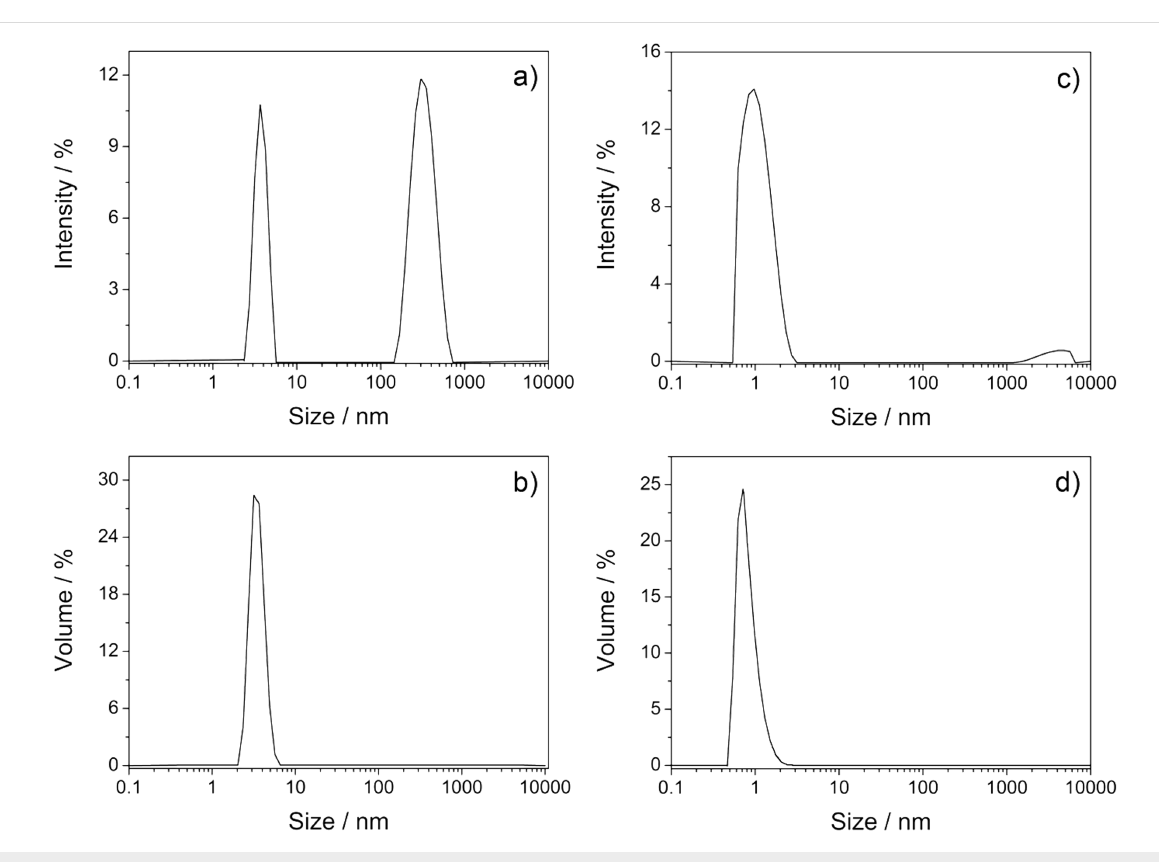
as 15 μ M, was achieved in the presence of 6.0 mM of a γ -CD thioether. The resulting aqueous molecular solutions of C 60 free of toxic organic solvents will hopefully find interesting applica- tions in biomedicine, such as in photodynamic therapy or HIV- protease